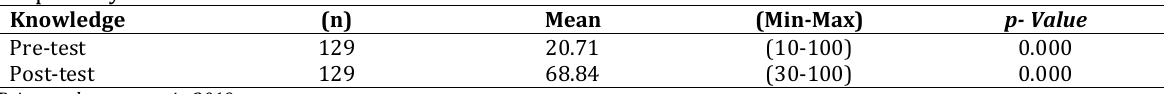
Table 3. Wilcoxon Test Knowledge of Respondents Before and After Being Given Health Education About Acute Respiratory